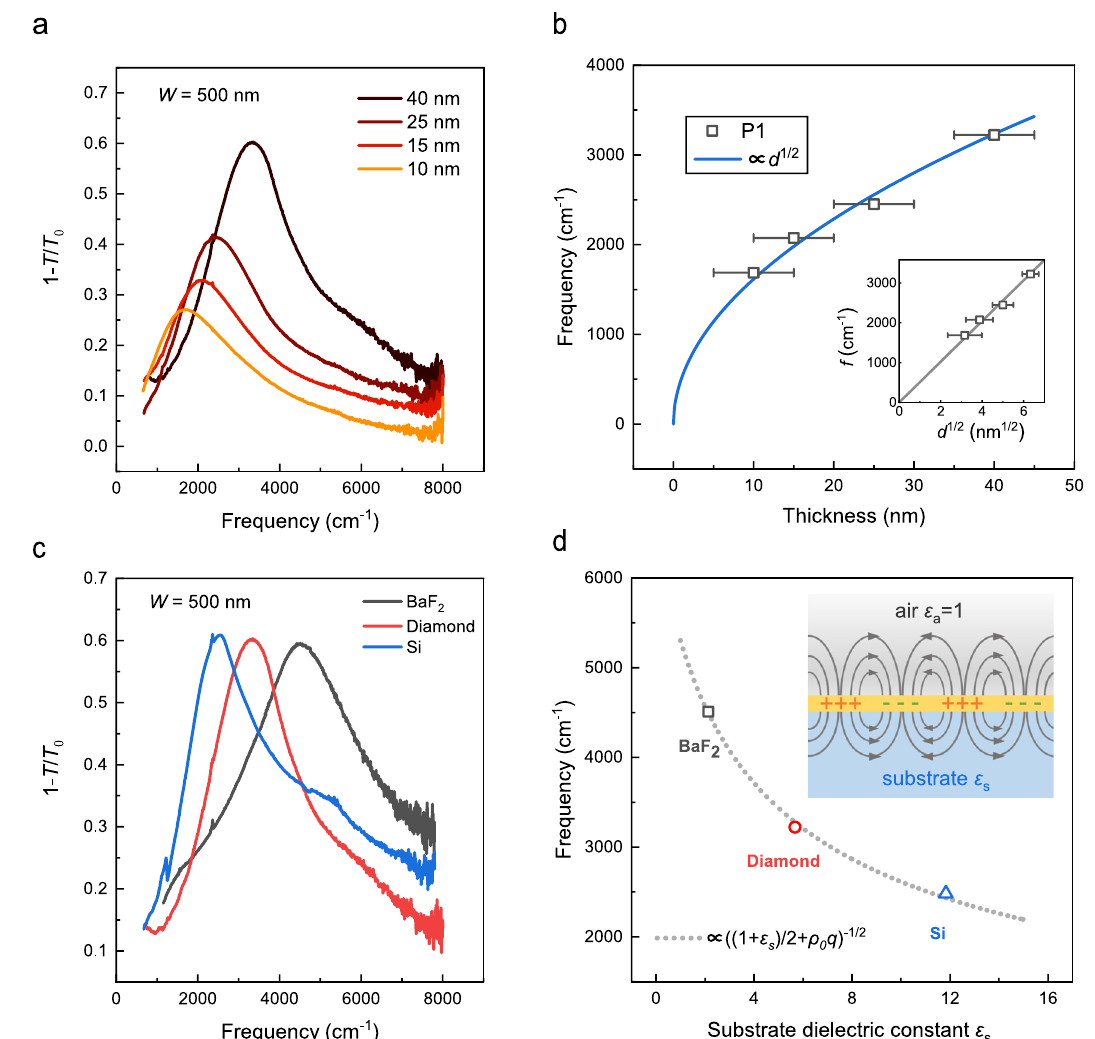
Fig. 3 Tunable plasmons by thickness and dielectric environments. a The extinction spectra of plasmonic devices with fi lm thickness of 10 nm (an isolated sample), 15 nm (sample T3), 25 nm (sample T2), and 40 nm (sample T1), respectively. The ribbon width is fi xed at 500 nm. b The thickness ffiffiffi p d dependence of the plasmon frequency, the blue solid line shows the fi tted plasmon frequency as a function of , the gray solid line in the inset also shows this relation. c The extinction spectra of plasmonic devices on BaF 2 (sample T5), diamond (sample T1), and Si (sample T6) ε s substrates, respectively, with the same thickness and ribbon width ( d = 40 nm, W = 500 nm). d The plasmon frequency as a function of substrate dielectric constants, the gray dashed q Þ (cid:2) 1 = 2 . The inset illustrates the screening effect of the substrate. The line represents the fi tted plasmon frequency which is proportional to ðð 1 þ ε s Þ = 2 þ ρ 0 TaSe 2 thin fi lm (yellow fi lm) is surrounded by the substrate (blue region) and air (gray region) with dielectric constants of ε s and ε a , respectively. The gray solid lines denote the electric fi eld lines caused by the spatial distribution of positive charges ( + ) and negative charges ( − ) in the fi